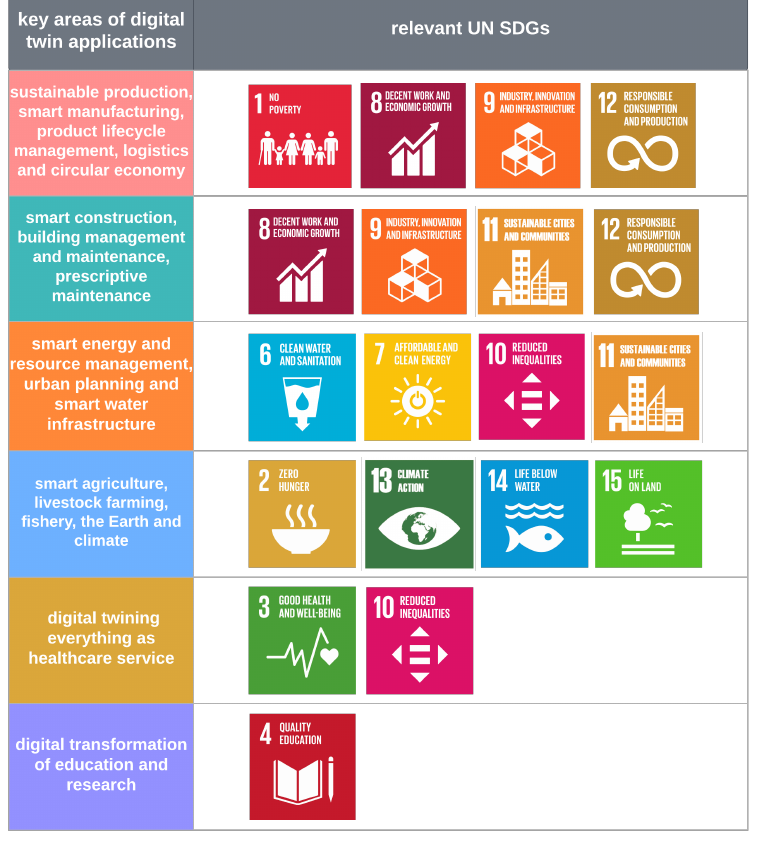
Figure 3. Digital twin implementations supporting UN